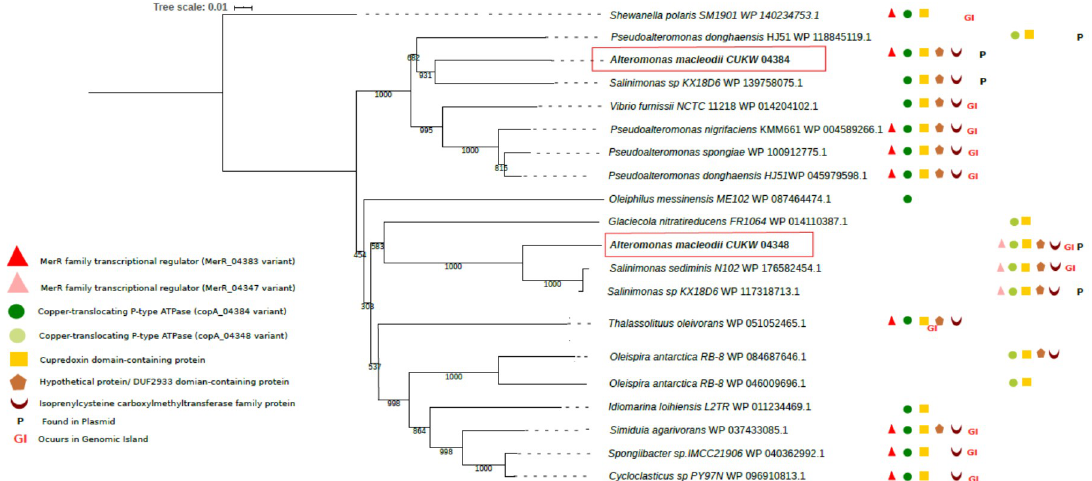
Fig 8. Distribution of CopA and MerR variants among bacterial genera. Phylogenetic analysis of the copper-translocating P-type ATPase (CopA) was done with bacterial species showing at least 45% sequence similarity with either CopA variant of A . macleodii CUKW. Only species with complete genome sequences available at NCBI RefSeq database were included. The amino acid sequences for CopA were downloaded from the NCBI database. Multiple sequence alignments of the sequences were performed using ClustalX and phylogenetic trees were constructed using a bootstrap neighbor-joining algorithm. The specific gene clusters surrounding the copA region in those species were identified by protein blast analysis against ones from A . macleodii CUKW. The copA variants and surrounding gene clusters were mapped onto the phylogenetic tree using Inkscape editor. The two variants are differentiated by color. The two merR variants (MerR_04383 and MerR_04347) are shown as red and pink triangles, respectively. The two copA variants (CopA_04384 and CopA_04348) are shown as dark green and light green circles, respectively. “P” indicates the presence of the gene cluster on a plasmid and “GI” indicates the gene cluster occurs within a genomic island. The two copA variants of A . macleodii CUKW are highlighted in red rectangular